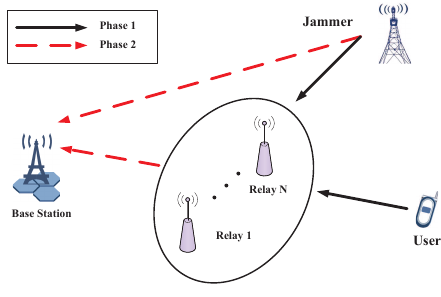
Figure 1. Anti-jamming relay communication